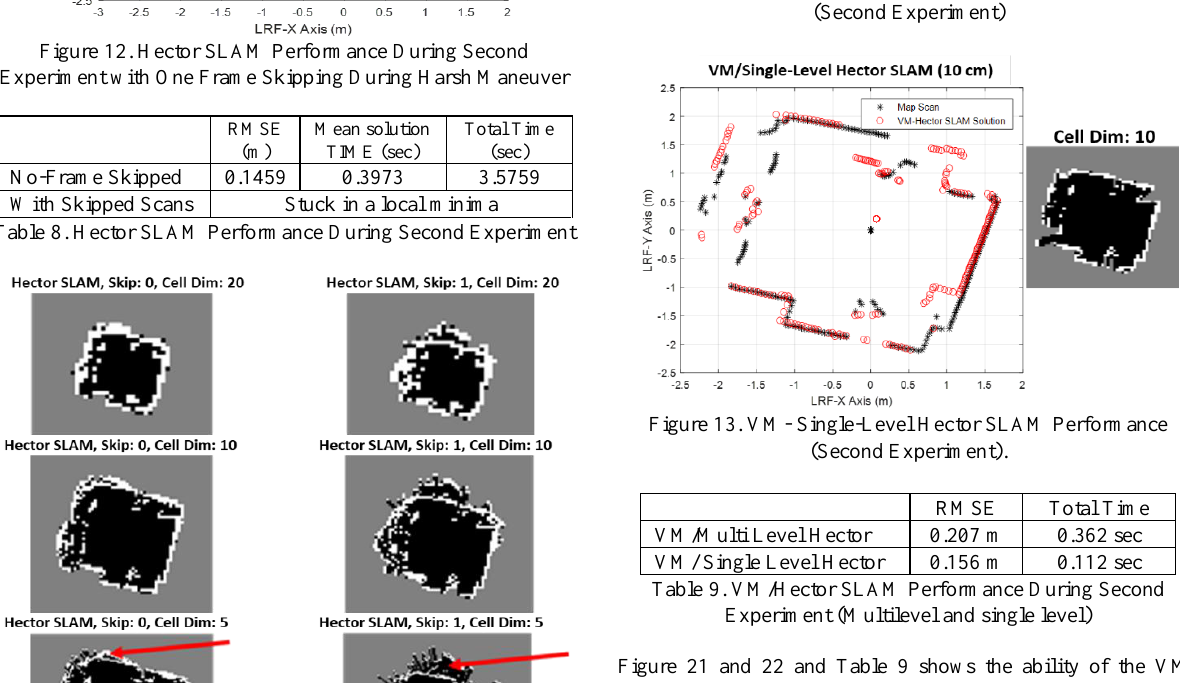
Figure 21. VM- Multi-Level Hector SLAM Performance